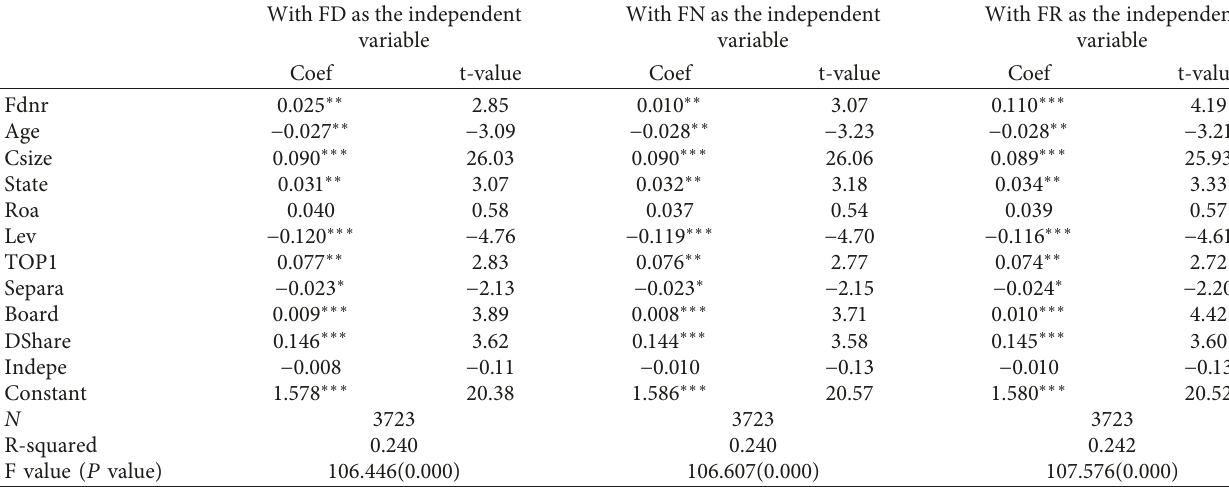
Table 6: The results of the main effect regression.